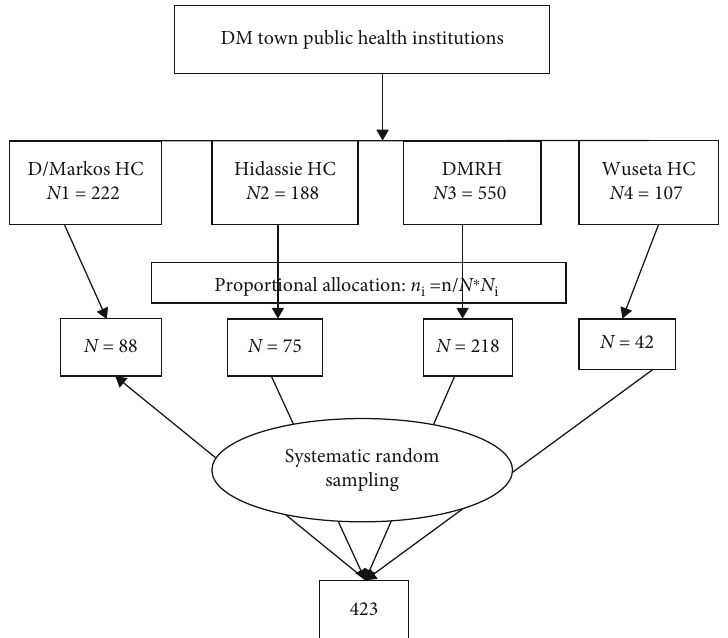
Figure 1: Schematic presentation of the sampling procedure for the study on pregnancy-related anxiety and associated factors among women attending ANC in Debre Markos town public health facilities, northwest Ethiopia,